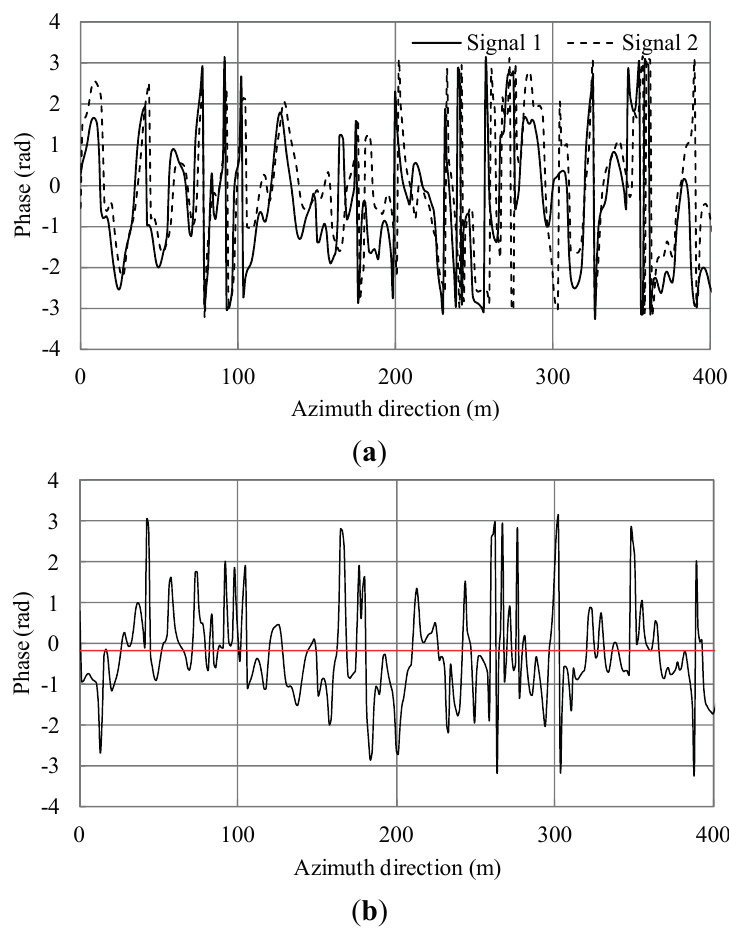
Figure 10. Simulation results of additional current and irregular waves for wind speed 7.5 m/s. ( a ) Phase of simulated SAR signals of master and slave antennas in the azimuth direction. ( b ) Phase differences of (a). The black line shows the phase differences. The red line shows the average.